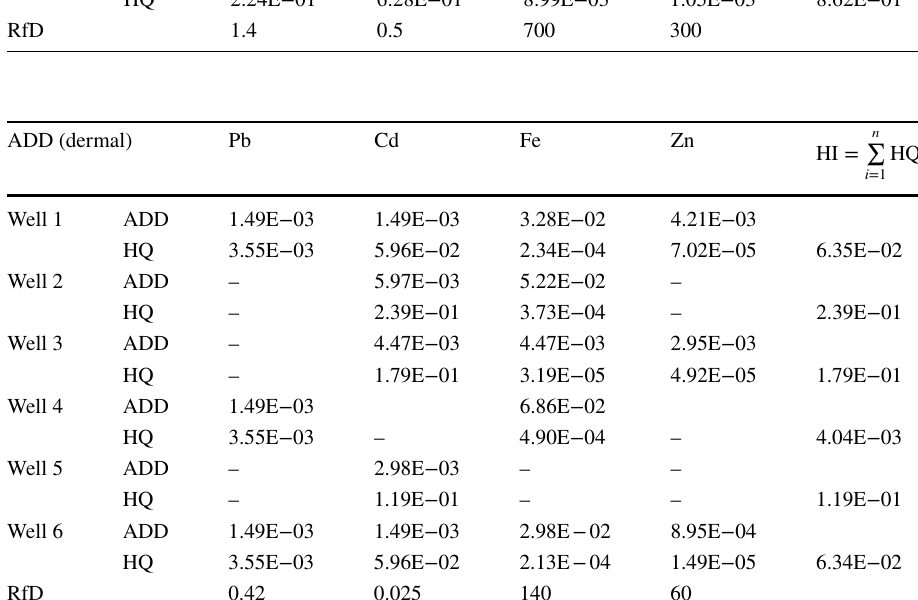
Table 5 Non-carcinogenic health risk for heavy metals in the well water samples from the Anloga community through dermal